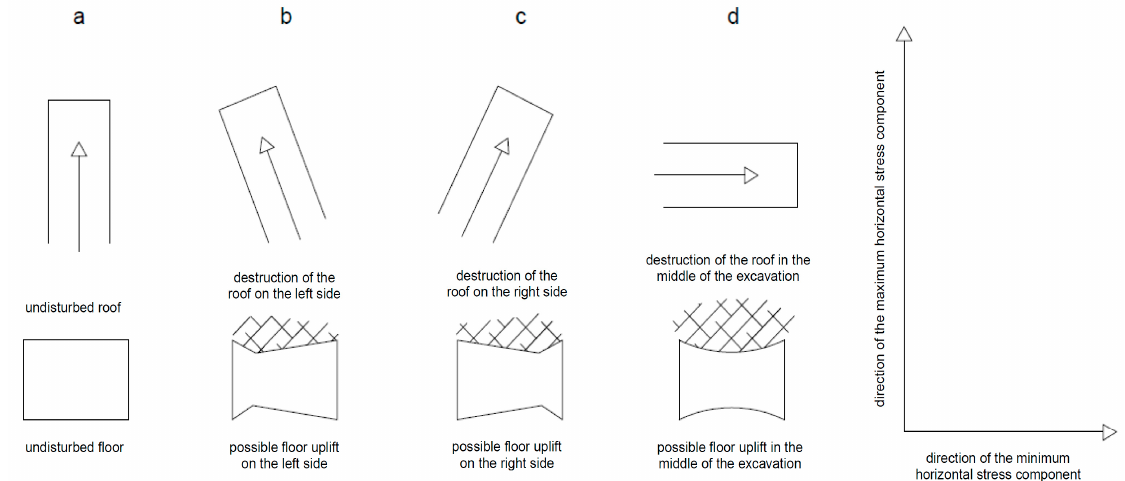
Figure 2. Influence of horizontal stress on heading stability (based on the works in [3,23]). ( a ) undisturbed floor; ( b ) possible floor uplift on the left side; ( c ) possible floor uplift on the right side; ( d ) possible floor uplift in the middle of the excavation.